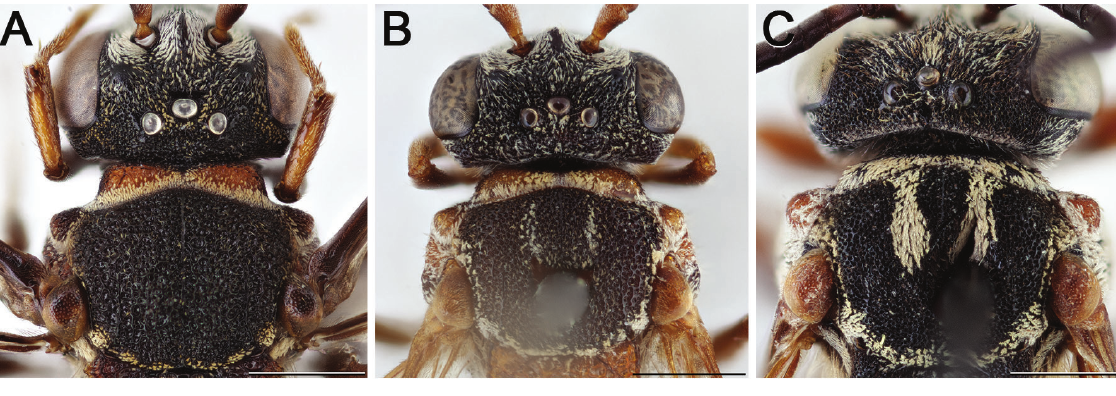
Fig. 2. Pronotal collar of female, dorsal view. A . E. boliviensis Friese, 1908, which is straight along its anterior margin. B . E. fumipennis Say, 1837, which is relatively straight along its anterior margin. C . E. hanusiae sp. nov., paratype (UCBME), which is convex along its anterior margin. Scale bars = 1